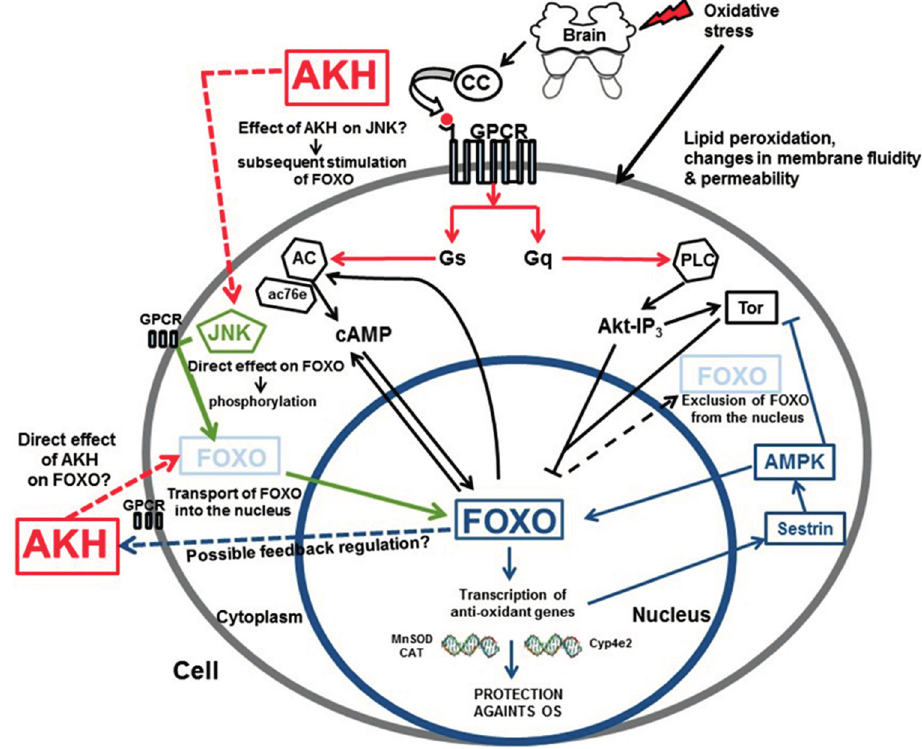
Figure 1. A hypothetical model for AKH action and for the role of FoxO in response to OS in insects. Activation of adenylate cyclase (AC) by AKH through G-protein coupled receptors (GPCRs) leads to an elevation of cAMP, which can directly affect FoxO; FoxO can then feedback and modulate the level of cAMP by direct activation of ac76e. This will induce FoxO localization in the nucleus, where FoxO can act as a transcription factor.